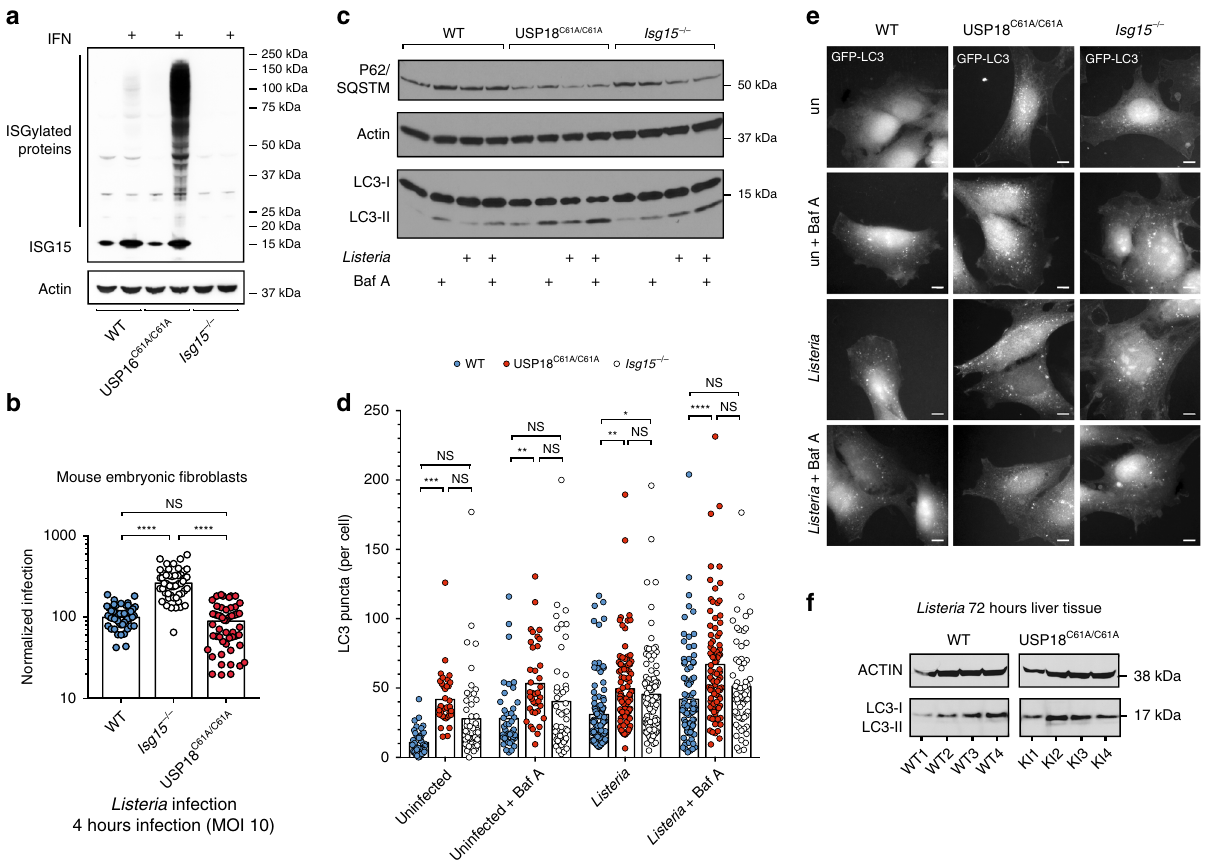
Fig. 5 ISGylation alters basal and infection-induced autophagy. a SDS-PAGE of wild-type, USP18 C61A/C61A , and Isg15 − / − mouse embryonic fi broblasts treated with interferon β (1000 units/mL for 24 h), bottom ISG15 blot is a short exposure of the upper panel. b Mouse embryonic fi broblasts MEFs (wild- type, Isg15 − / − KO, and USP18 C61A/C61A KI) were infected with Listeria monocytogenes strain EGD for 4 h at an MOI of 10. Cells were lysed, and bacterial CFUs were enumerated through serial dilution. Wild-type values were normalized to 100; data from three independent experiments are shown. Statistical analysis was conducted using one-way ANOVA and Tukey ’ s test post hoc. c SDS-PAGE analysis of wild-type or USP18 C61A/C61A MEFs treated with Ba fi lomycin A (100 nM for 20 min prior to lysis) at baseline or following 4 h of infection with Listeria at an MOI of 10. Immunoblot is a representative image of fi ve independent experiments. d GFP-LC3 puncta per cell; data shown are compiled from four separate experiments WT (un, un + Baf, EGD, EGD + Baf) n = 408, 450, 984, 987 (USP18 C61A/C61A (un, un + Baf, EGD, EGD + Baf) n = 352, 410, 1038, 1014, Isg15 − / − (un, un + Baf, EGD, EGD + Baf) n = 183, 224, 710, and 470 individual cells per condition were enumerated). Statistical analysis was conducted using one-way ANOVA and Tukey ’ s test post hoc (exact p -values (Supplementary Fig. 4b). NS nonsigni fi cant, * p < 0.05; ** p < 0.01; *** p < 0.001 **** p < 0.0001. e Representative images of cells stably expressing GFP-LC3 and treated as above with Ba fi lomycin A or infected with Listeria and treated with Ba fi lomycin A, scale bar is 5 μ m. f SDS-PAGE of liver homogenate from n = 4 individual animals either wild-type or USP18 C61A/C61A infected with 5 × 10 5 Listeria, organs harvested following 72 h of infection. Raw data are available in the source data fi